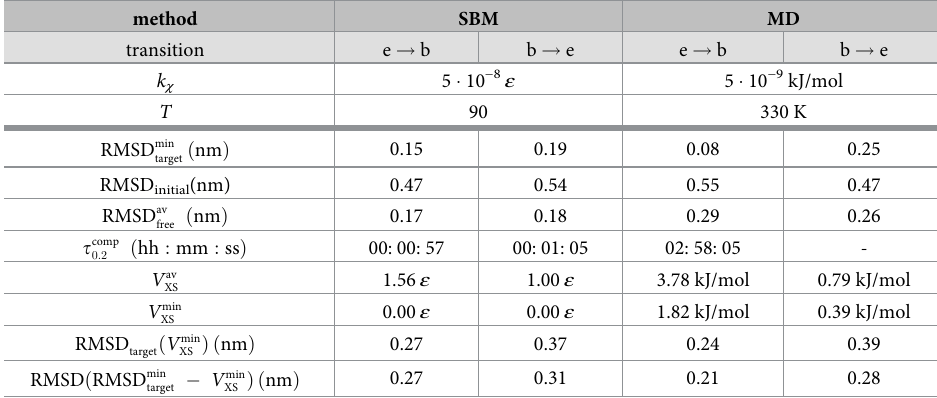
Table 1. Result parameters for scattering-guided simulations of